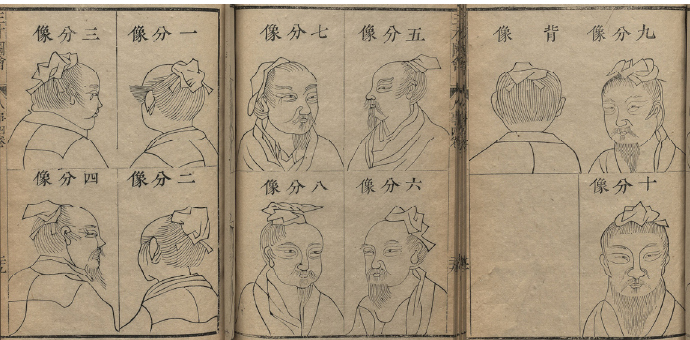
Figure 4. Facial angles for portraiture from Pictorial Compendium of the Three Powers , 1609. Woodblock prints on paper. Photo: Courtesy of München, Bayerische Staatsbibliothek.